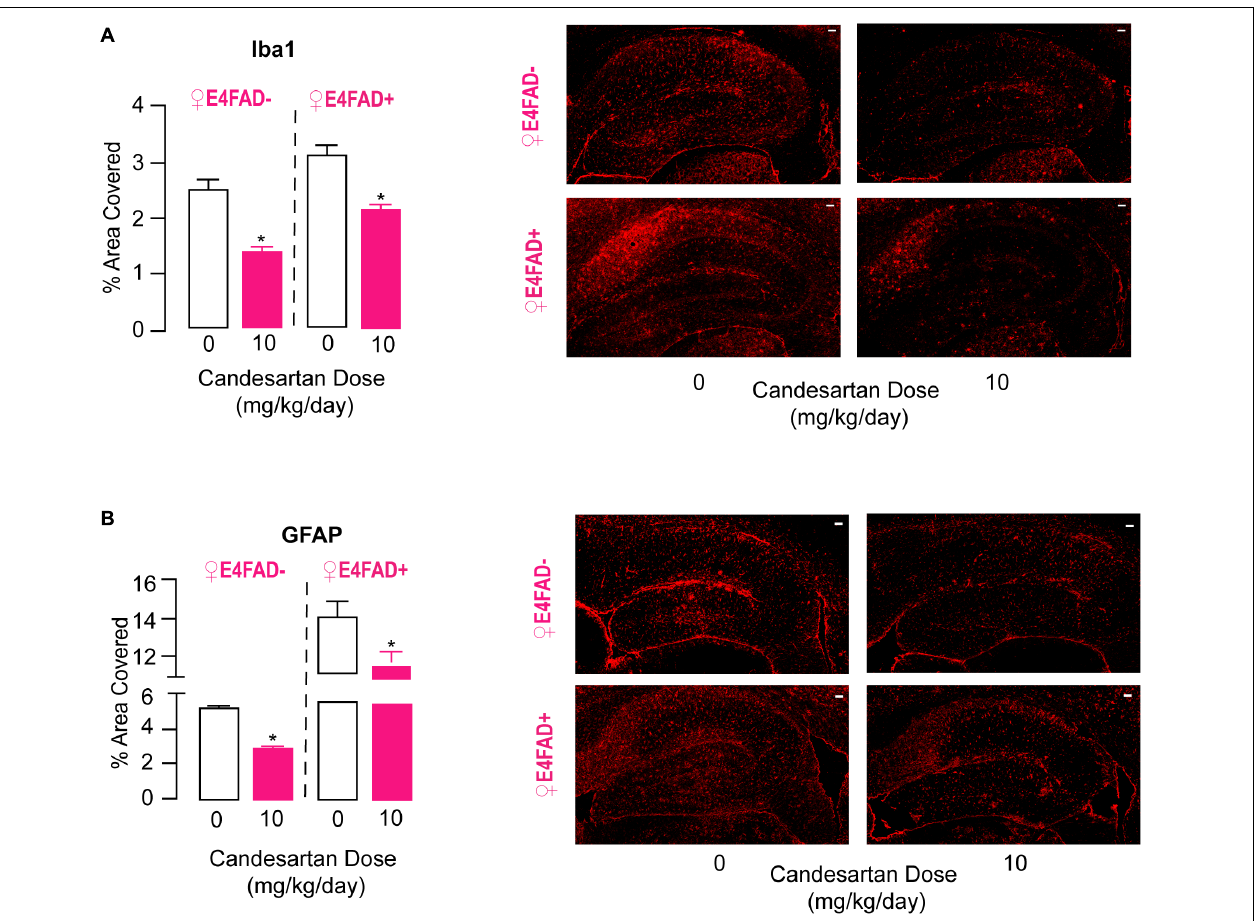
FIGURE 4 | High-dose candesartan treatment resulted in lower hippocampal levels of neuroinflammatory markers compared to vehicle treatment in female E4FAD − and E4FAD + mice. Female E4FAD − and E4FAD + mice treated with 10 mg/kg/day (high dose) candesartan had a lower percentage of hippocampal area immunostained with (A) Iba1 [E4FAD − : t (16) = 6.76, p < 0.0001. E4FAD + : t (18) = 5.08, p < 0.0001] and (B) GFAP [E4FAD − : t (16) = 15.06, p < 0.0001. E4FAD + : t (18) = 2.44, p = 0.025] compared to vehicle (0 mg/kg/day) when assessed by quantitative IHC analysis. All data expressed as mean + / − SEM. * p < 0.05 by Student’s t -test. Scale bars = 100 µ m. See Supplementary Table 2 for details on n